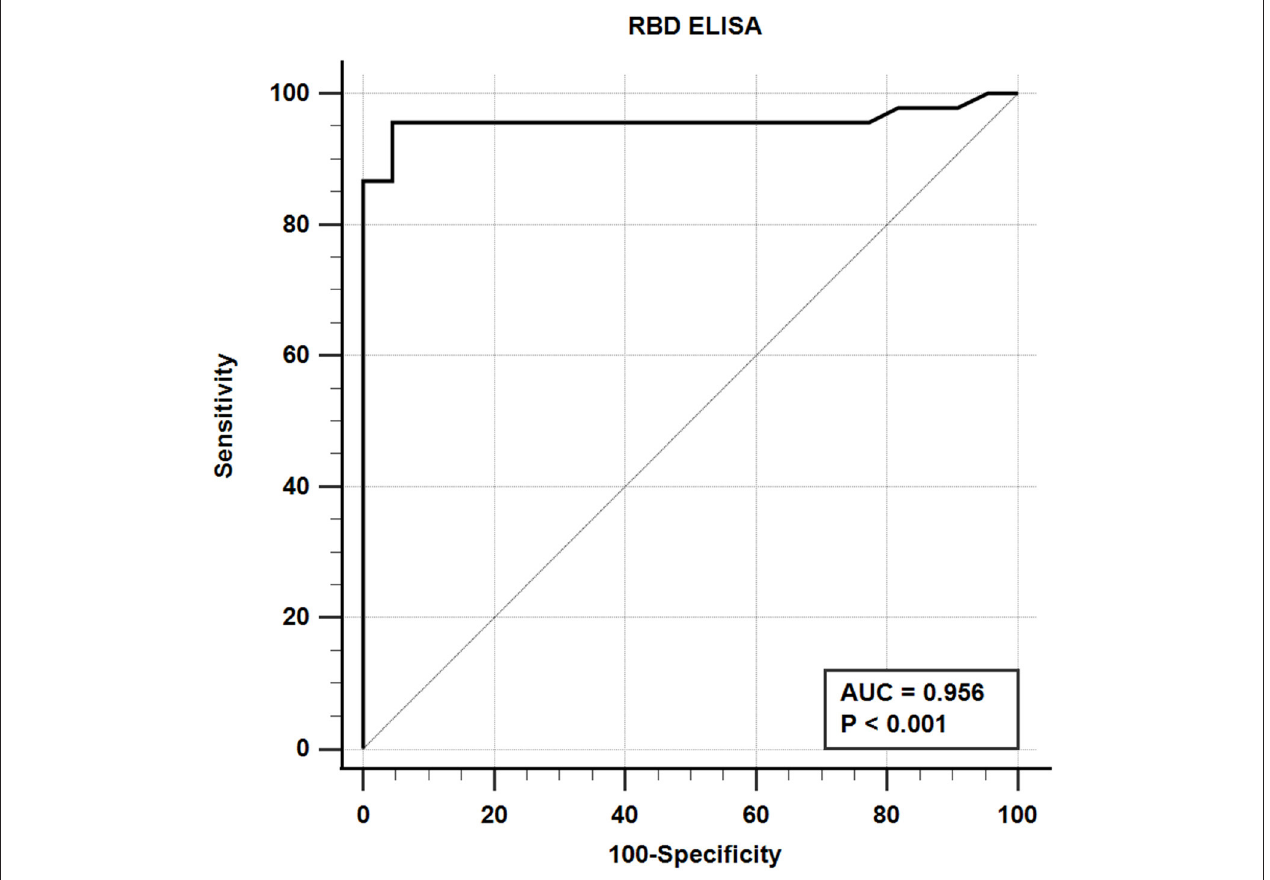
FIGURE 3 | Receiver-operating characteristic (ROC) analysis for the RBD protein iELISA. The line represents the 95% confidence interval, and the upper left corner is the highest Youden index indicating the best combined sensitivity and specificity of 95.6% and 95.5%, respectively. AUC, area under the curve.